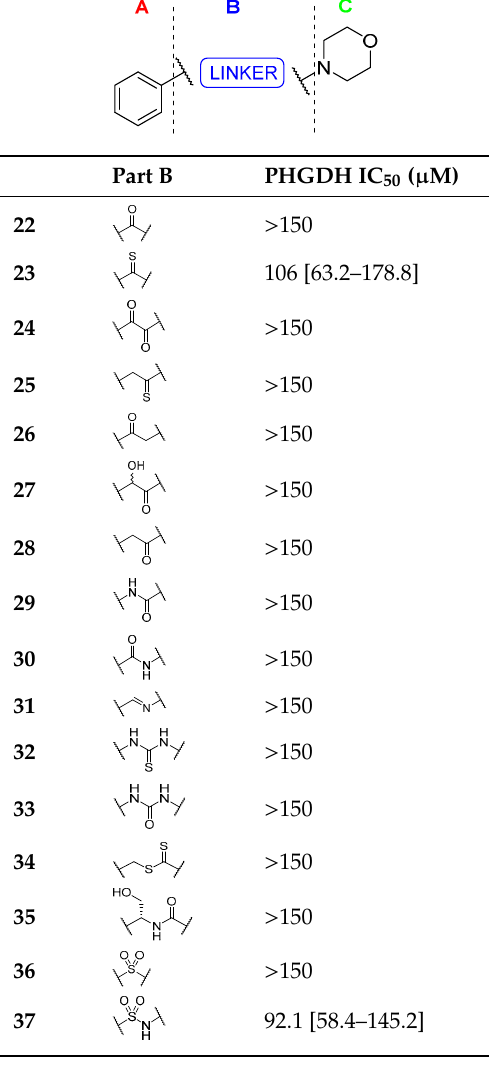
Table 4. Results of PHGDH inhibition for compounds 22 – 37 . All experiments were performed with at least triplicates and IC 50 values were determined in two or more independent experiments.